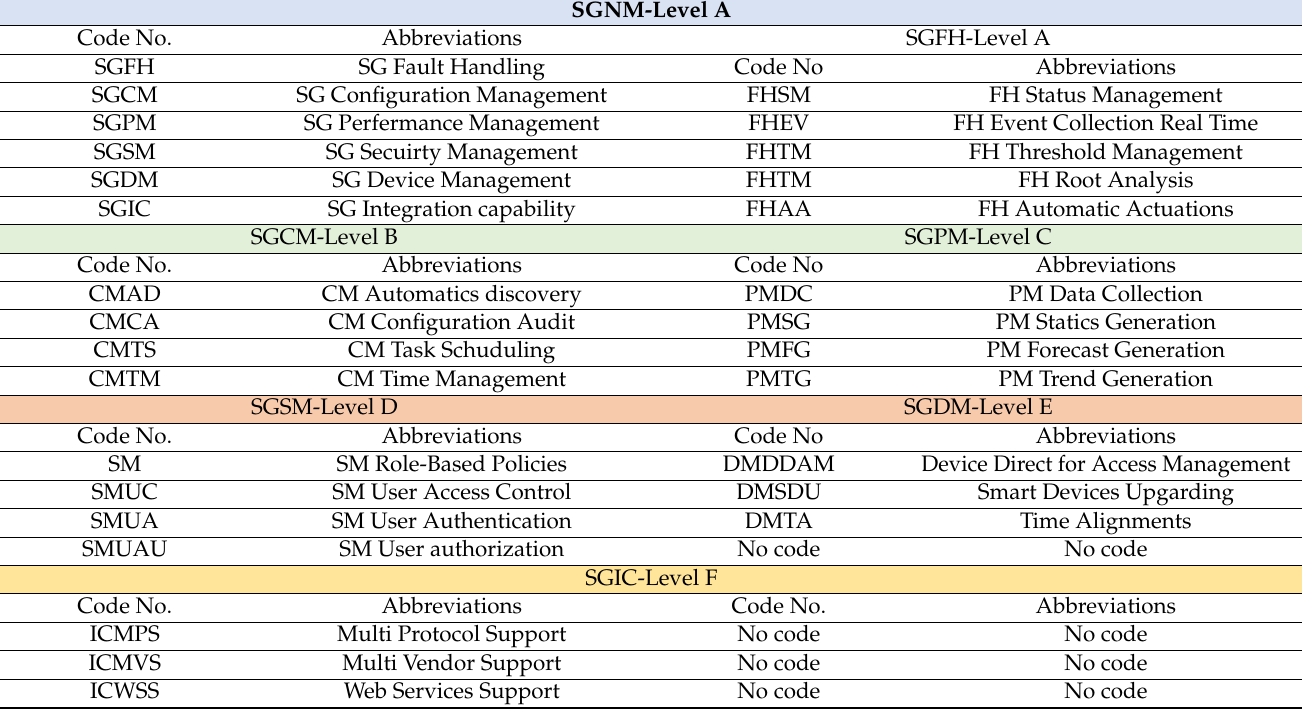
Figure A2. Demand-Side Management Categorization Agents. Table A1. SGNM Agents Directory.